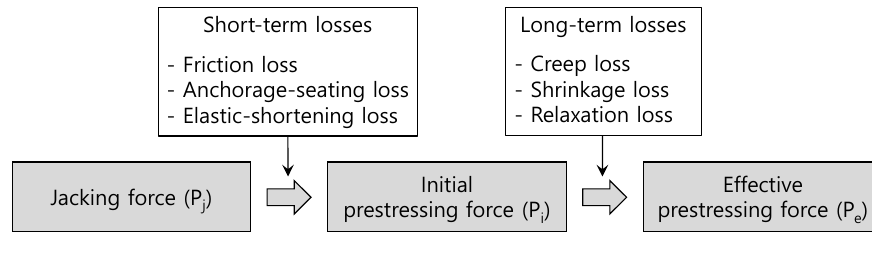
Figure 2. Prestress losses.